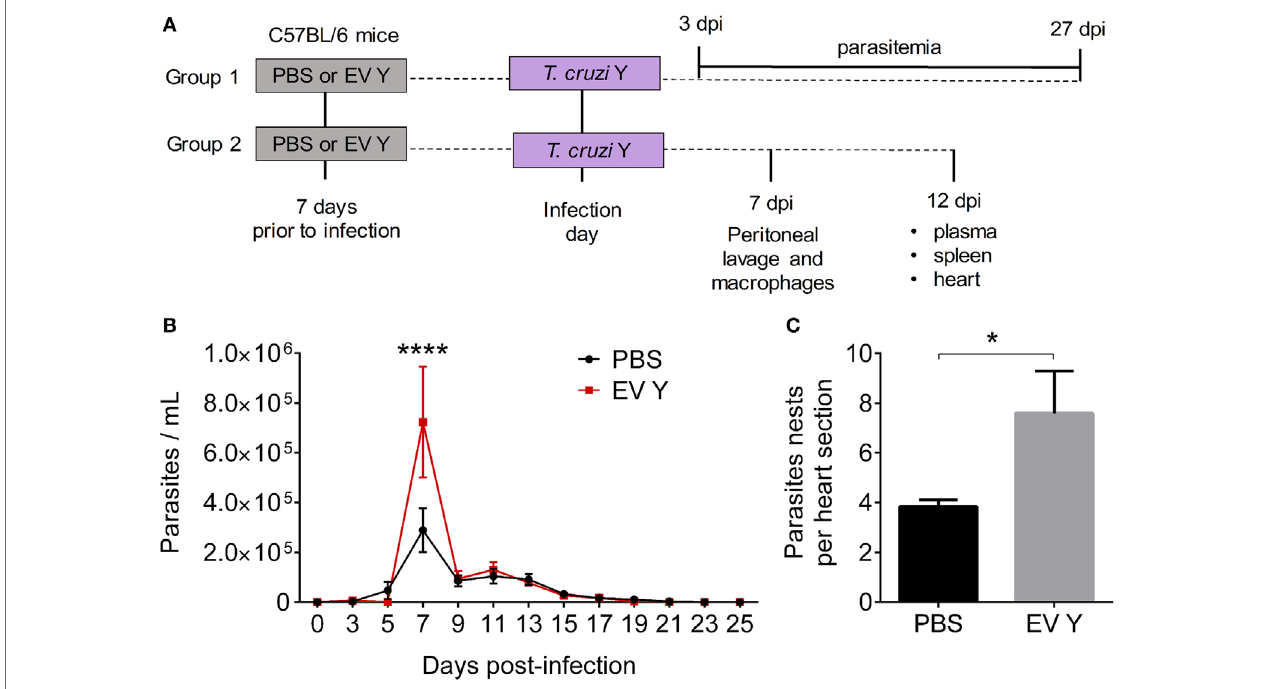
FigUre 1 | Previous inoculation of Trypanosoma cruzi extracellular vesicles (EVs) increases parasitemia and cardiac parasitism in C57BL/6 mice. C57BL/6 mice were inoculated with EVs derived from T. cruzi Y (EV Y) (i.p.). One week later, mice were infected with T. cruzi by the same route. (a) Experimental design for in vivo assays [days post-infection (dpi)]. (B) Parasitemia was quantified on alternating days as trypomastigotes per milliliter of blood. (c) Cardiac tissues were examined by hematoxylin and eosin staining on day 12 after T. cruzi infection. Parasitism was evaluated by counting the number of amastigote nests visualized at 1,000 × magnification in six sections of the heart per animal. The results were expressed as the mean of the number of amastigote nests per section. The results are expressed as the mean ± standard error from of five mice per group in an experiment representative of two similar experiments. * P < 0.05; **** P < 0.0001 significantly different. Two-way ANOVA with (B) Sidak’s post-test and (c) Student’s t- test– GraphPad